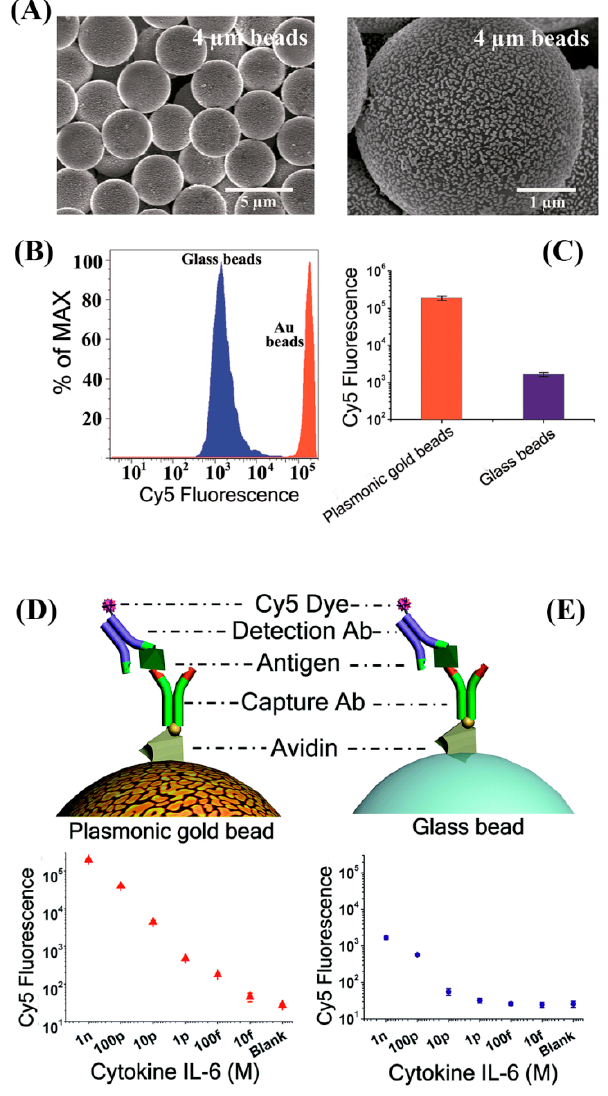
Figure 5. ( A ) Scanning electron microscope images of plasmonic Au nanoisland-covered glass beads are displayed; ( B ) Comparison of the fluorescence signal from the Cy5-avidin coated plasmonic gold beads versus glass beads in flow cytometry; ( C ) The mean Cy5 fluorescence intensity plot shows an enhancement of ~2 orders of magnitude on the plasmonic bead relative to the glass bead; ( D ) Sandwich assay schemes for IL-6 detection on a plasmonic Au bead and on a glass bead are shown; ( E ) Fluorescence data for IL-6 detection on (left) plasmonic gold beads and (right) glass beads are plotted as a function of the protein concentration. Reproduced with permission from Ref. [79] Copyright (2014) Royal Society of Chemistry.